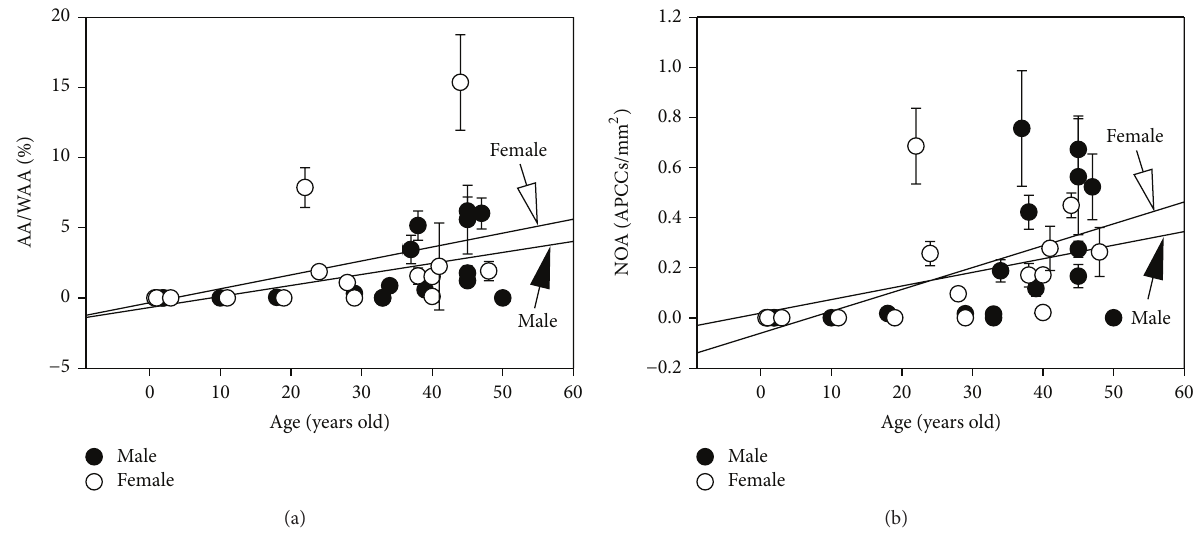
Figure 2: Relationship between age versus AA/WAA (%, (a)) and age versus NOA (APCCs/mm 2 , (b)). Error bars indicate SEM between 4 examiners (see Table 1 and Supplementary Table 1). Regression lines of females and males are drawn. AA/WAA: percentage of APCC areas over the whole adrenal area (%). NOA: number of APCCs/mm 2